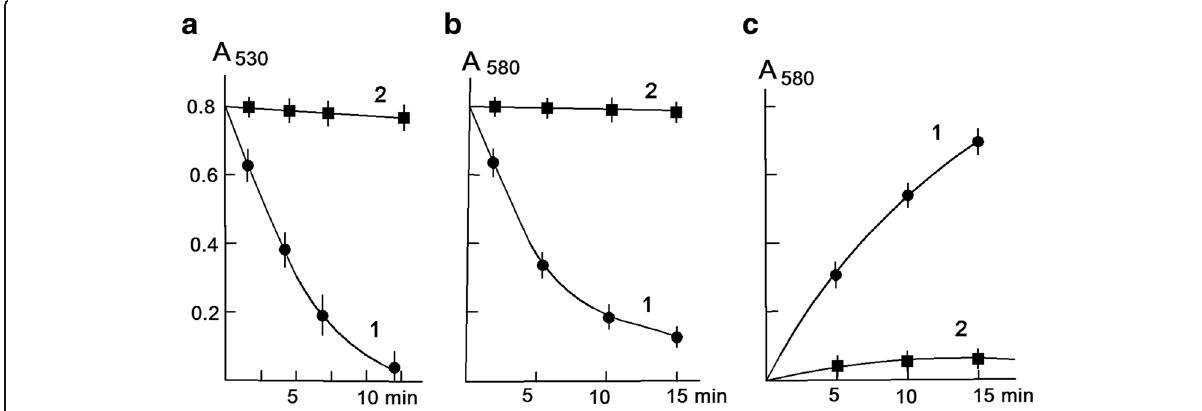
Fig. 4 Kinetic curves for KMnO 4 ( a -1) and PPB ( b -1) discoloration, reduction of nitrotetrazolium blue, with the formation of formazan ( c -1) under the influence of 0.2 mg/ml suprol associated fraction of Nox in the absence of (1 - ● -) and the presence of 5 × 10( − 8) M Cu, Zn-SOD (2 - ■ -), at a temperature of + 25 °C